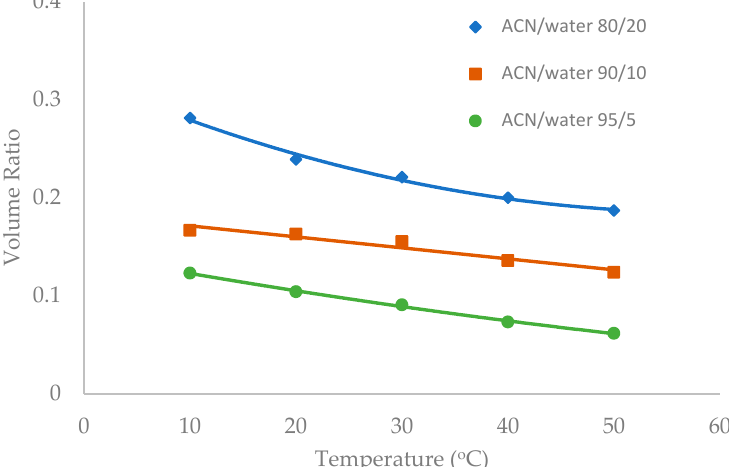
Figure 7. The effect of column temperature on the volume ratio ( β ) values for XBridge Amide column (3.5 µm, 142 Å, 4.6 × 150 mm). The mobile phase contains 5 mM ammonium acetate.